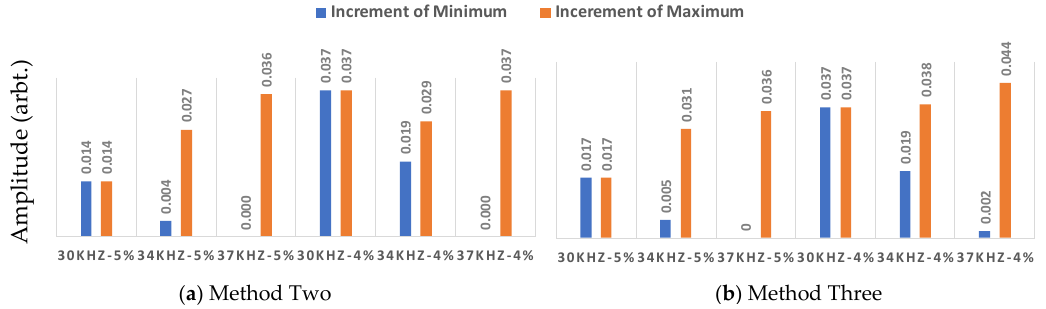
Figure 20. The increments achieved using the second version of thresholding in the second set of tests.